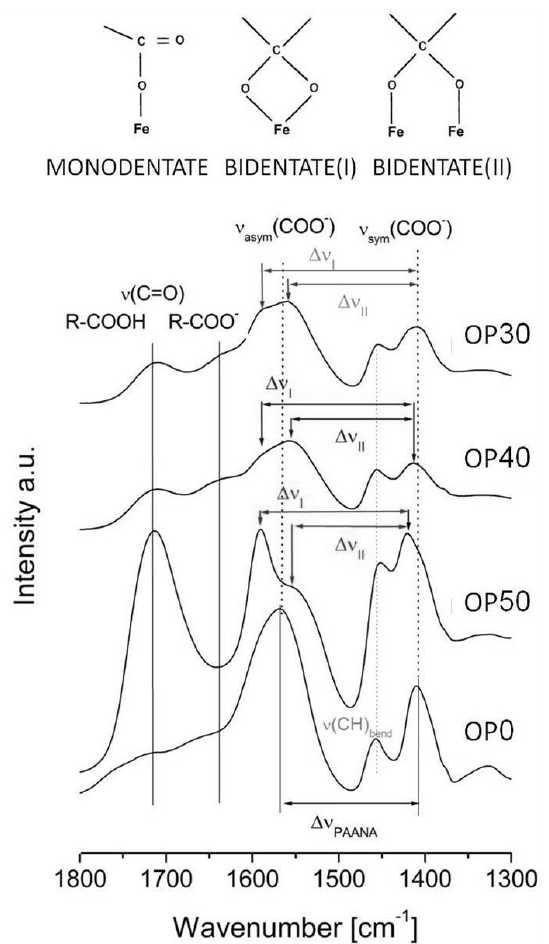
Figure 4. Infrared spectra of the MNCs obtained by oxidative precipitation. The evolution of the value of = (COO − ) asym − (COO − ) sym is presented. Monodentate coordination arises when > PAANa and (C=O) exist, bidentate (I) arises when < PAANa and (C=O) do not exist, and bidentate (III) arises when ≈ PAANa and (C=O) exist.